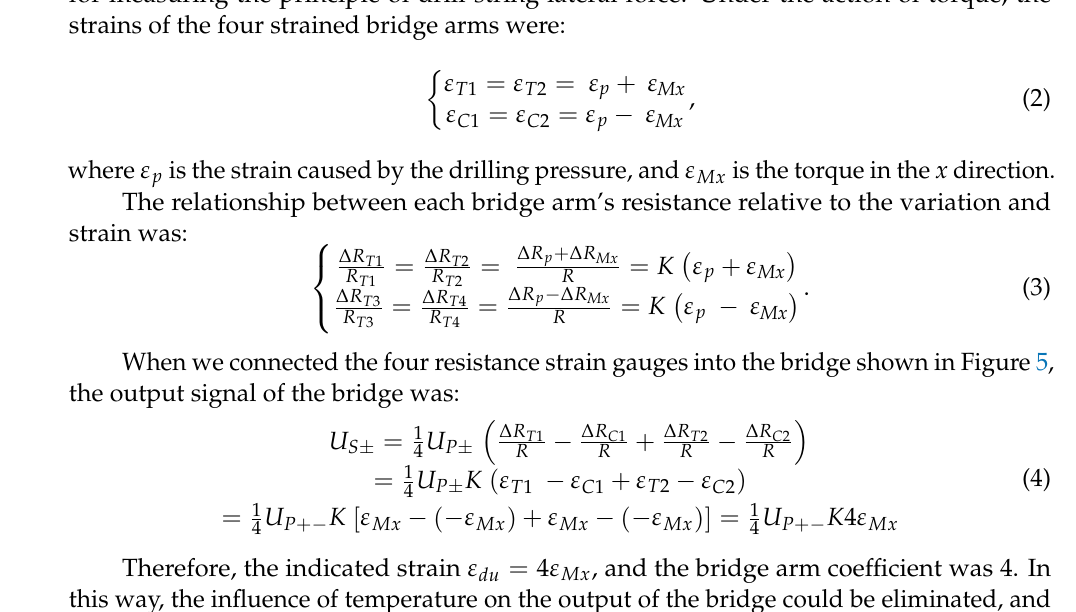
Figure 5. Equivalent circuit diagram of measuring bridge: ( a ) In X direction; ( b ) In Y